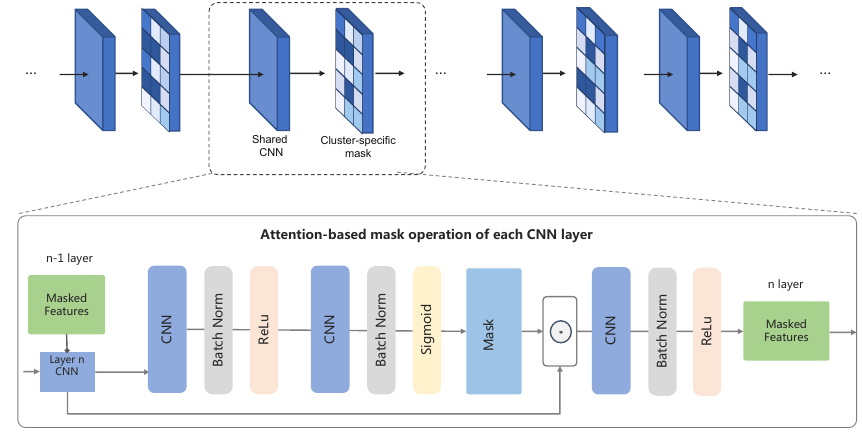
Figure 5. Architecture of the attention-based mask for cluster-specific feature